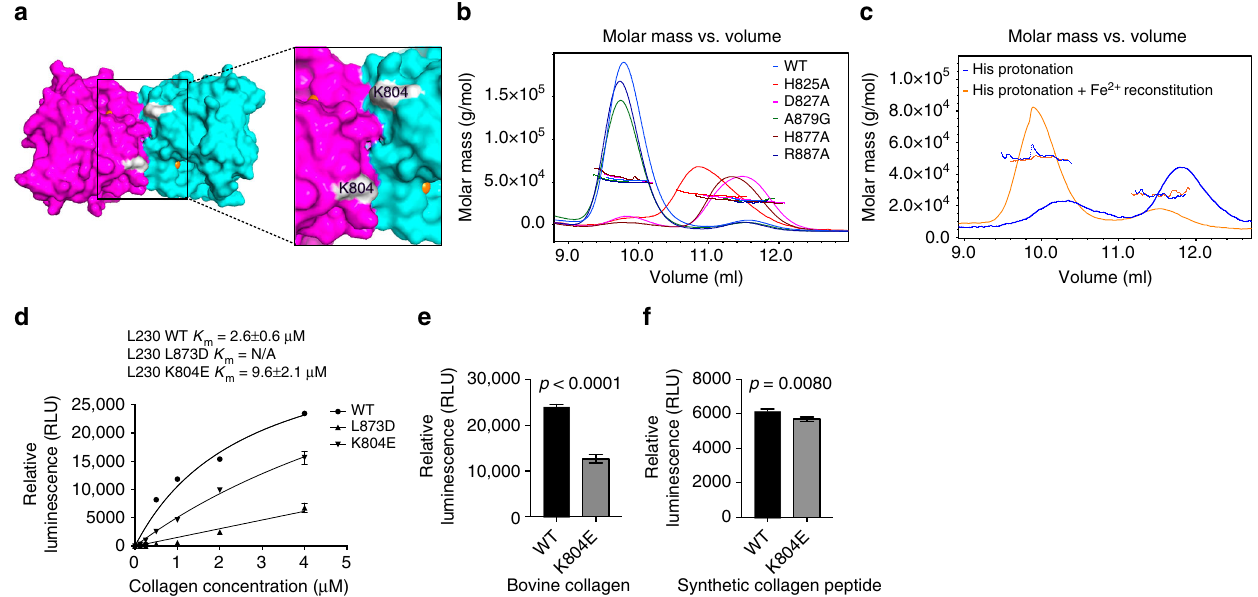
Fig. 3 A cleft on the protein surface that may be involved in collagen binding. a Surface diagram of the LH domain homodimer. A cleft created by the dimerization interface is fl anked by the active sites (inset). Locations of Fe 2+ atoms (orange) within each monomer (purple and cyan) are indicated. Location of K804 within the cleft (white). b SEC-MALS of L230 LH domain. On the basis of elution time ( X -axis) and molar mass ( Y -axis), dimerization is lost following mutation of residues in the amino acid triad (H825, D827, or H877) but not the residue positioned to bind 2-OG (R887) or non-conserved A879. c SEC-MALS of L230 LH domain after Fe 2+ removal. Dimerization is lost following histidine protonation to release the Fe 2+ (blue line) and restored following Fe 2+ reconstitution (orange line). d Enzymatic activity assays of L230 LH domain proteins using different concentrations of bovine skin collagen as substrate. Curves were used to calculate the K m values for wild-type L230 (WT) and L230 containing mutations on the dimerization interface (L873D) or within the cleft (K804E). e , f Enzymatic activity assays of L230 LH domain proteins using bovine skin collagen ( e ) or synthetic collagen peptide ( f ) as substrate. Relative to wild-type L230 (WT), K804E exhibited a reduction in activity on collagen, whereas activity in the context of a synthetic peptide was relatively preserved. Results in b – f are mean values ( ± S.D.) from triplicate biological samples. p values, two-tailed Student ’ s t test | DOI: 10.1038/s41467-018-02859-z |